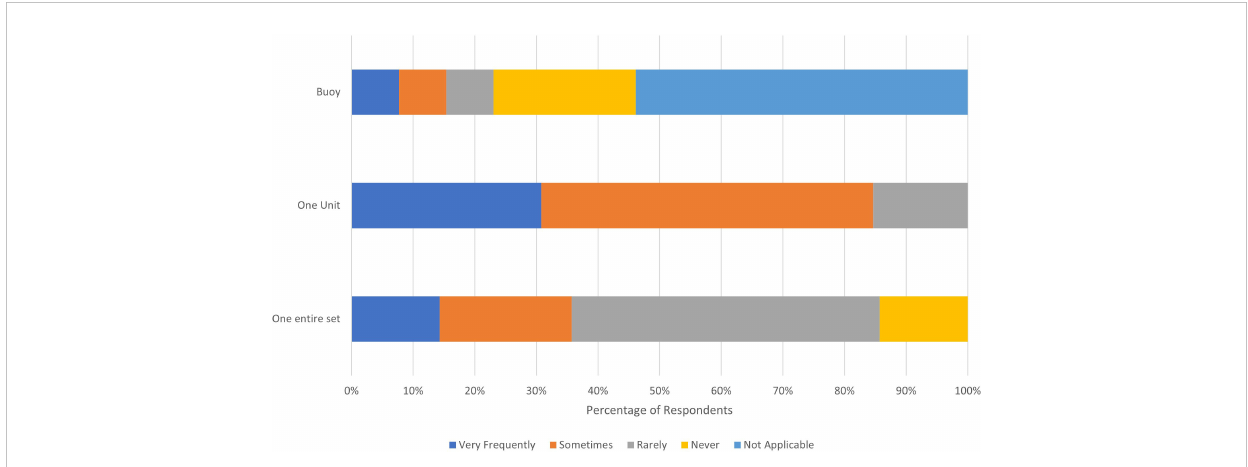
FIGURE 5 Summary of interview results from Antigua and Barbuda to the question: “ When or if fi sh traps or parts of traps are lost which of the following elements are lost and in what frequency? ” (n =